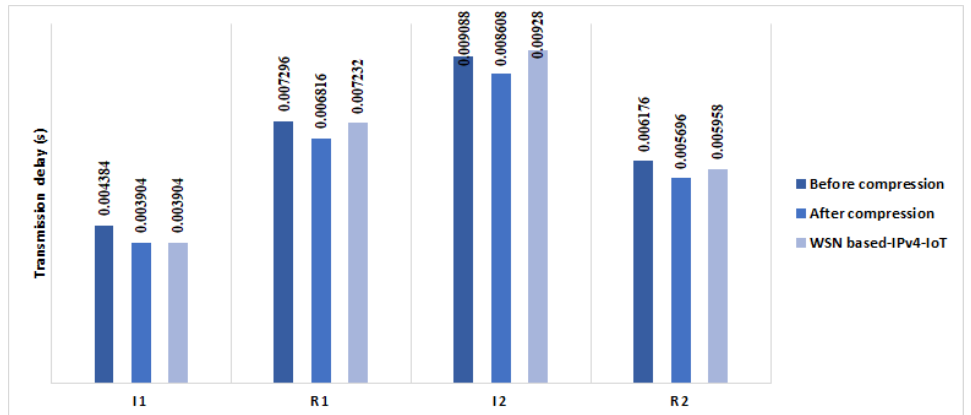
Figure 9. Transmission delays results before and after the proposed HIP DEX header’s compression comparing with transmission delays in an IPv4 Mesh_under architecture [9].